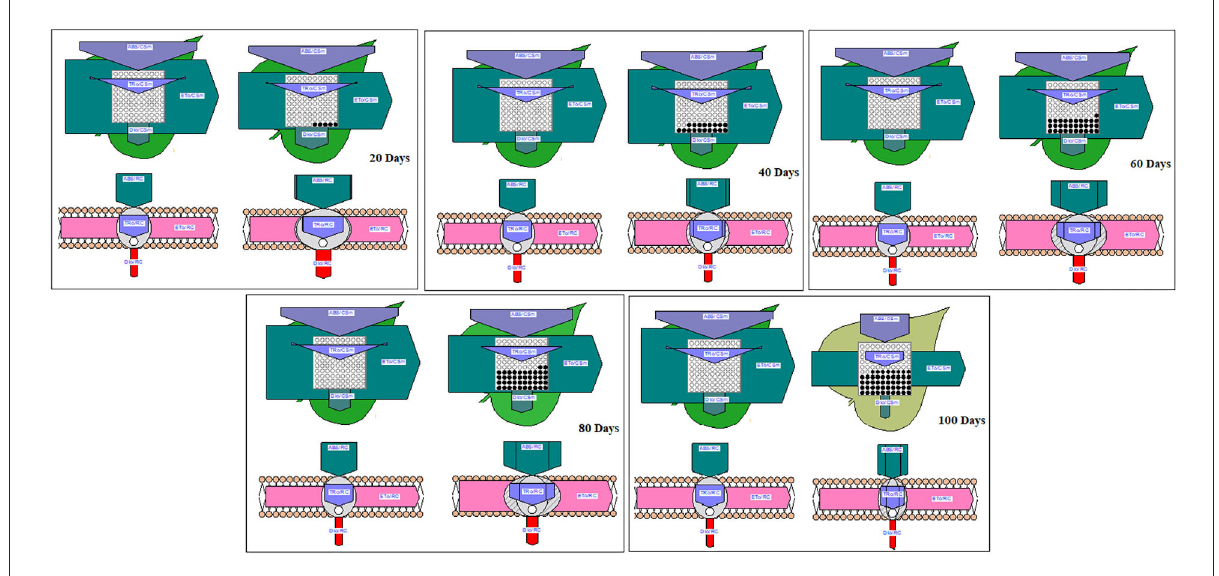
FIGURE6 Pipeline and membrane models of peanut chlorophyll fluorescence under different waterlogging treatments.